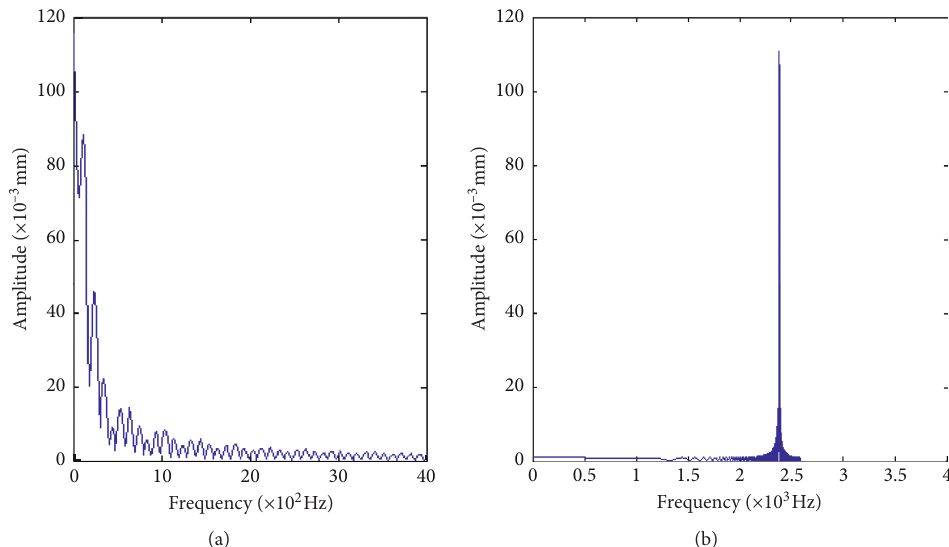
Figure 9: Frequency domain of the dynamic cutting forces at the depth of cut ( a � 0 . 02 mm), cutting speed ( V � 400mm/min. (a) Tangential component. (b) Normal velocity V w